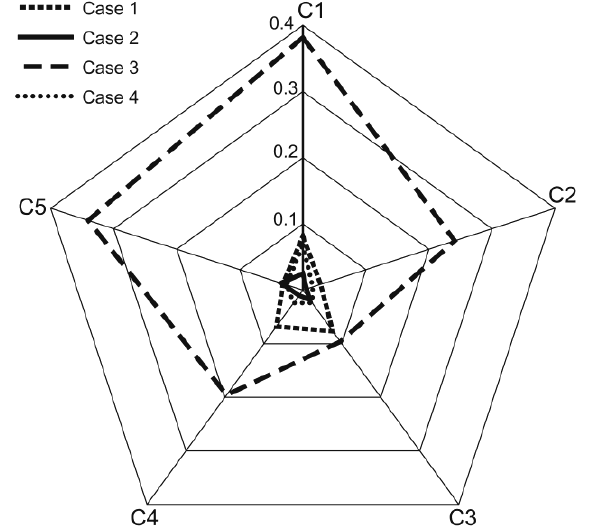
Figure 6. Variability of the sensitivity coefficient for each criterion for four cases.